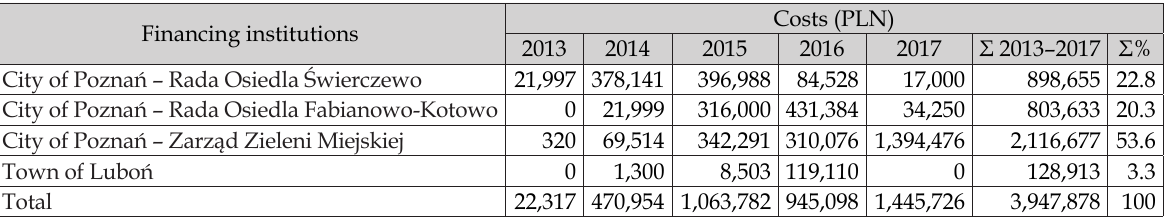
Table 2. Public expenditure on the arrangement and maintenance of the Szachty area by years and institutions. Financing